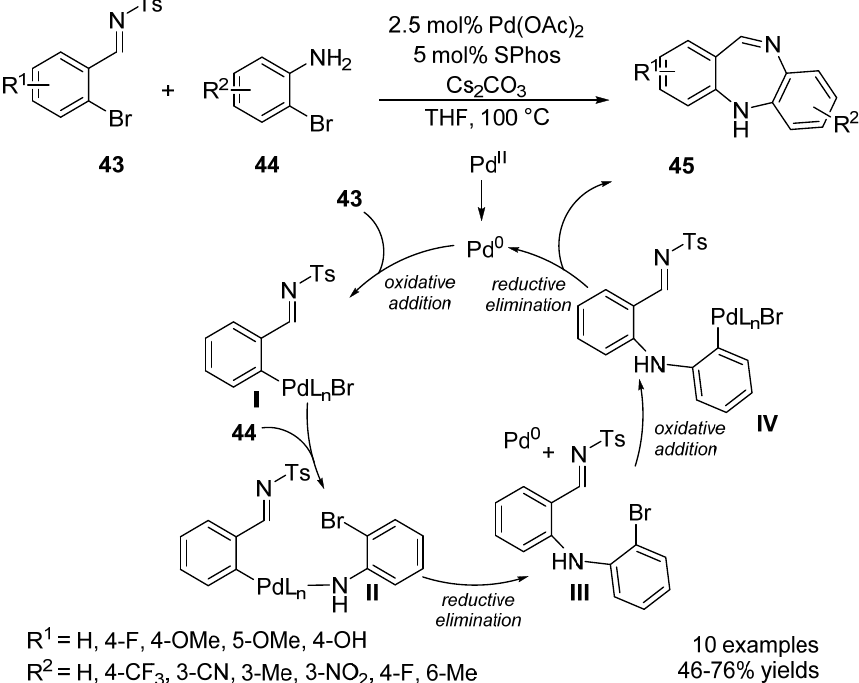
Scheme 21. Domino sequence for the synthesis of dibenzodiazepines 45